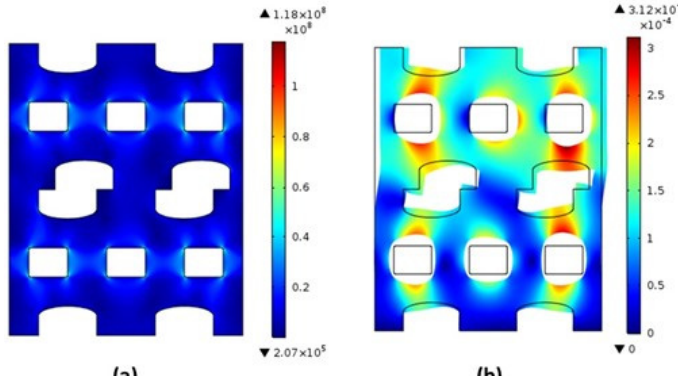
Figure 4. Huber–von Mises stress (a) and total displacement (b) distribution due to pressure load (at misalignment of 0.85 mm).